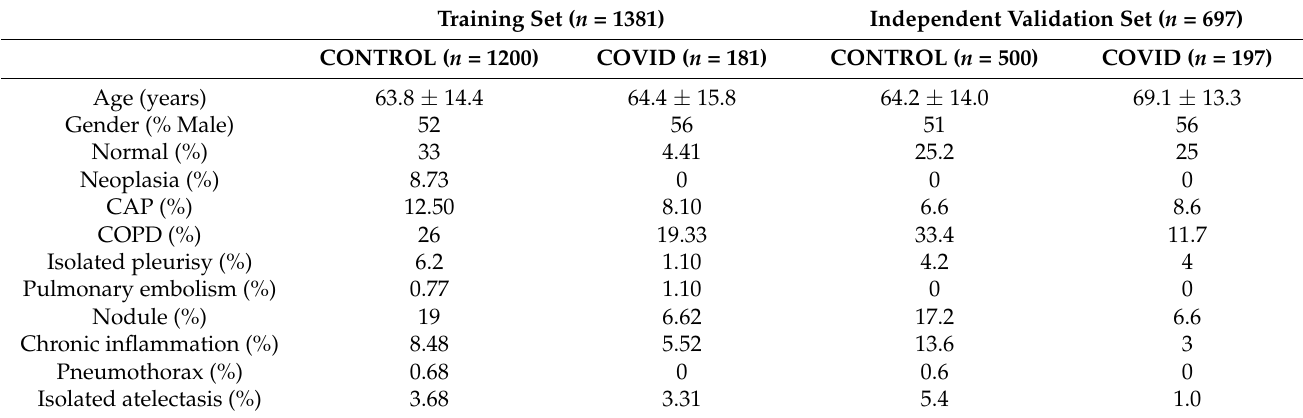
Table 1. Summary of patient characteristics (age, gender and CT findings scored by radiologist) per cohort.